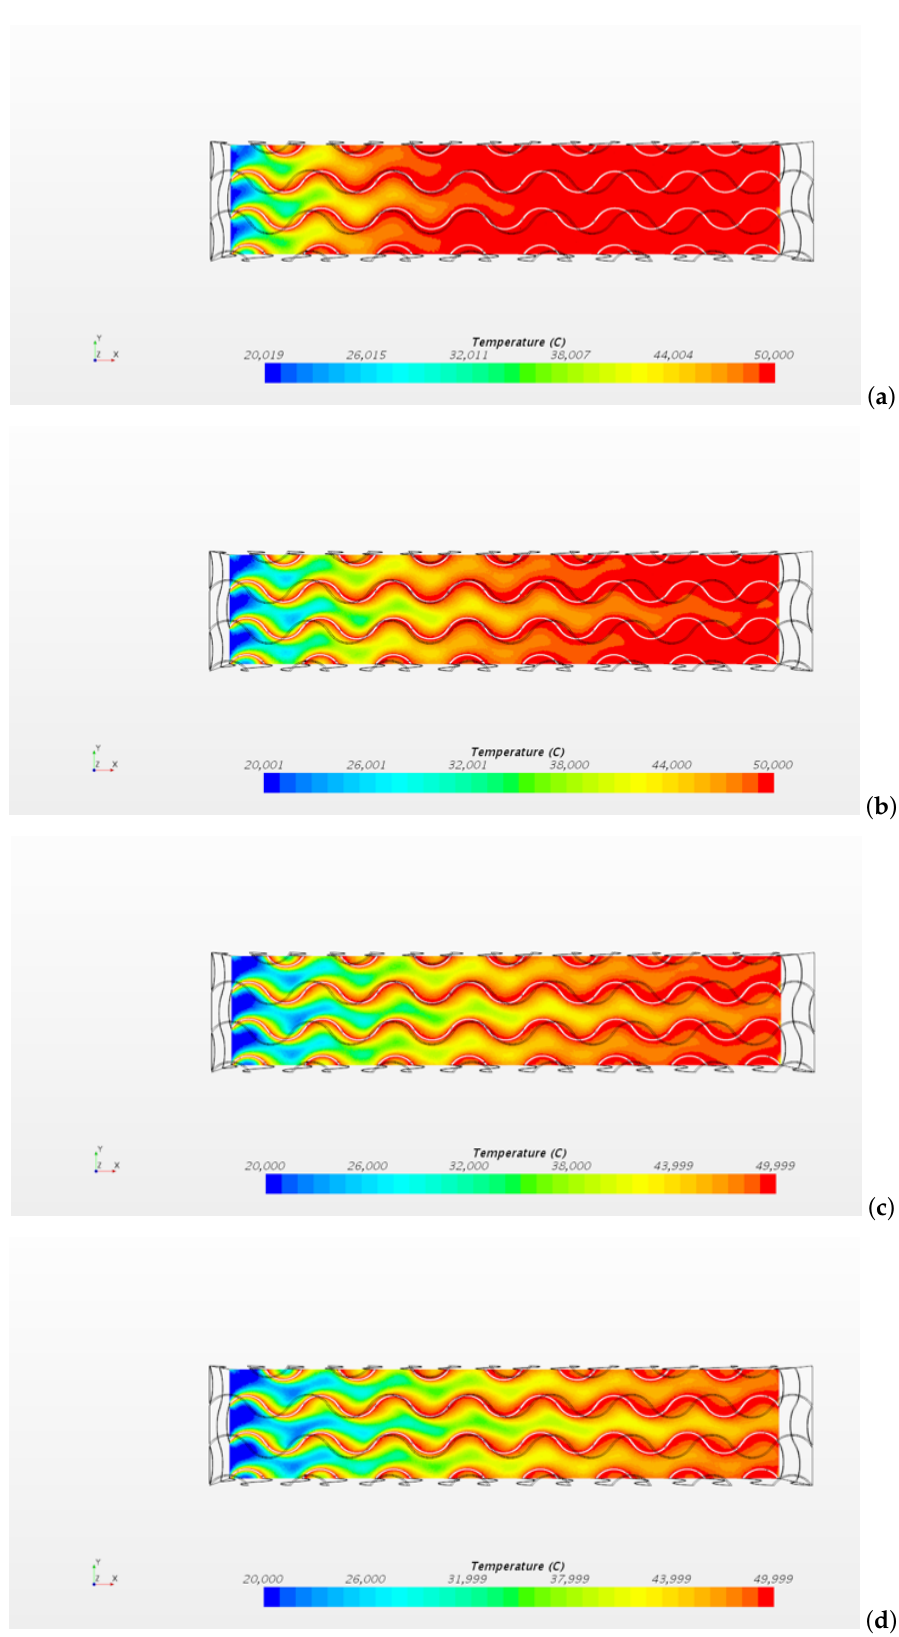
Figure 11. Temperature distribution obtained on the plane z / W = 1/3 for the cases Re = 3.6 ( a ), Re = 7.2 ( b ), Re = 10.8 ( c ), Re = 14.4 ( d ). For all the cases, T s = 50 ◦